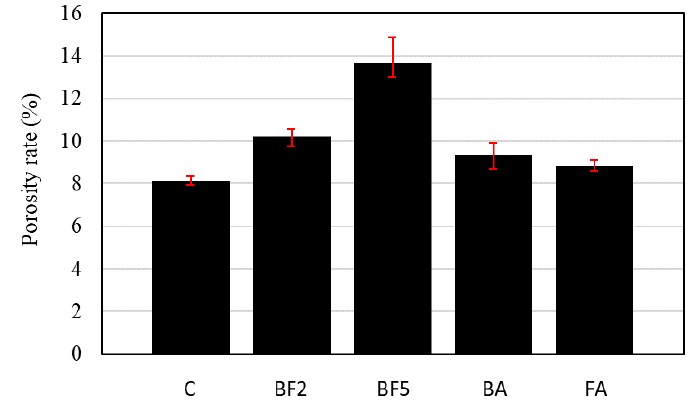
Figure 8. Porosity rate of each concrete mixture.